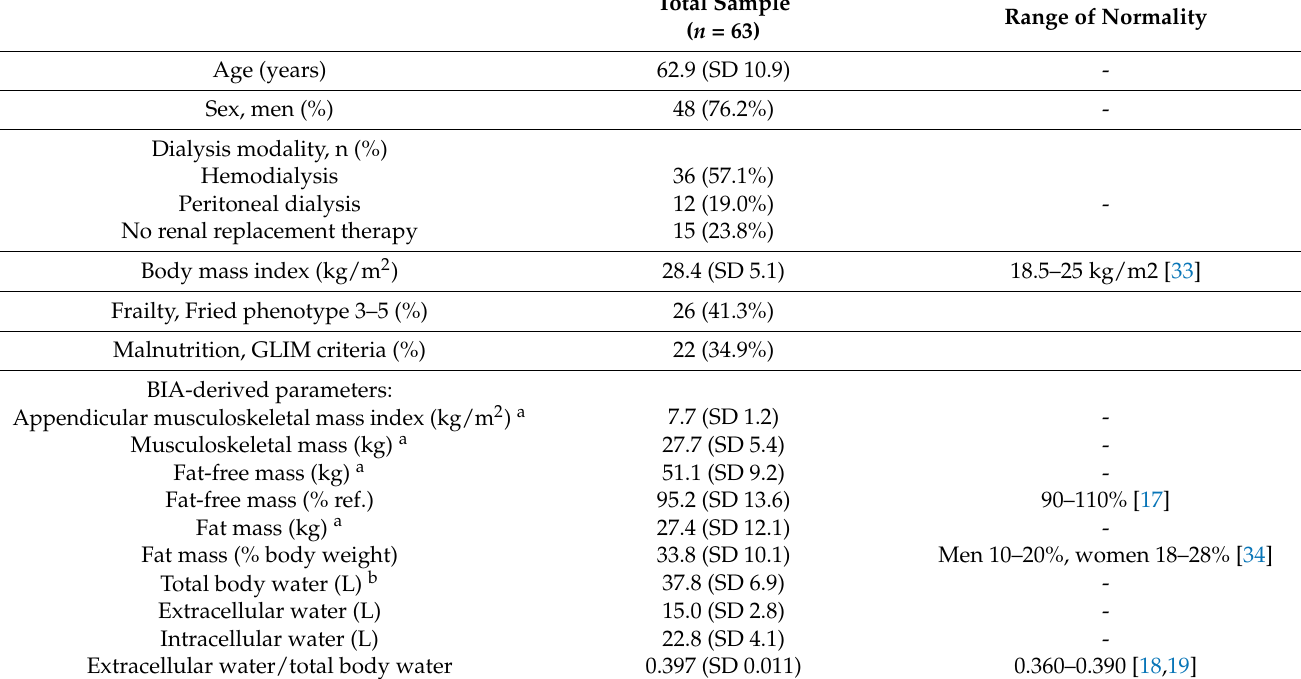
Table 1. Demographic and clinical characteristics of the FRAILMar study